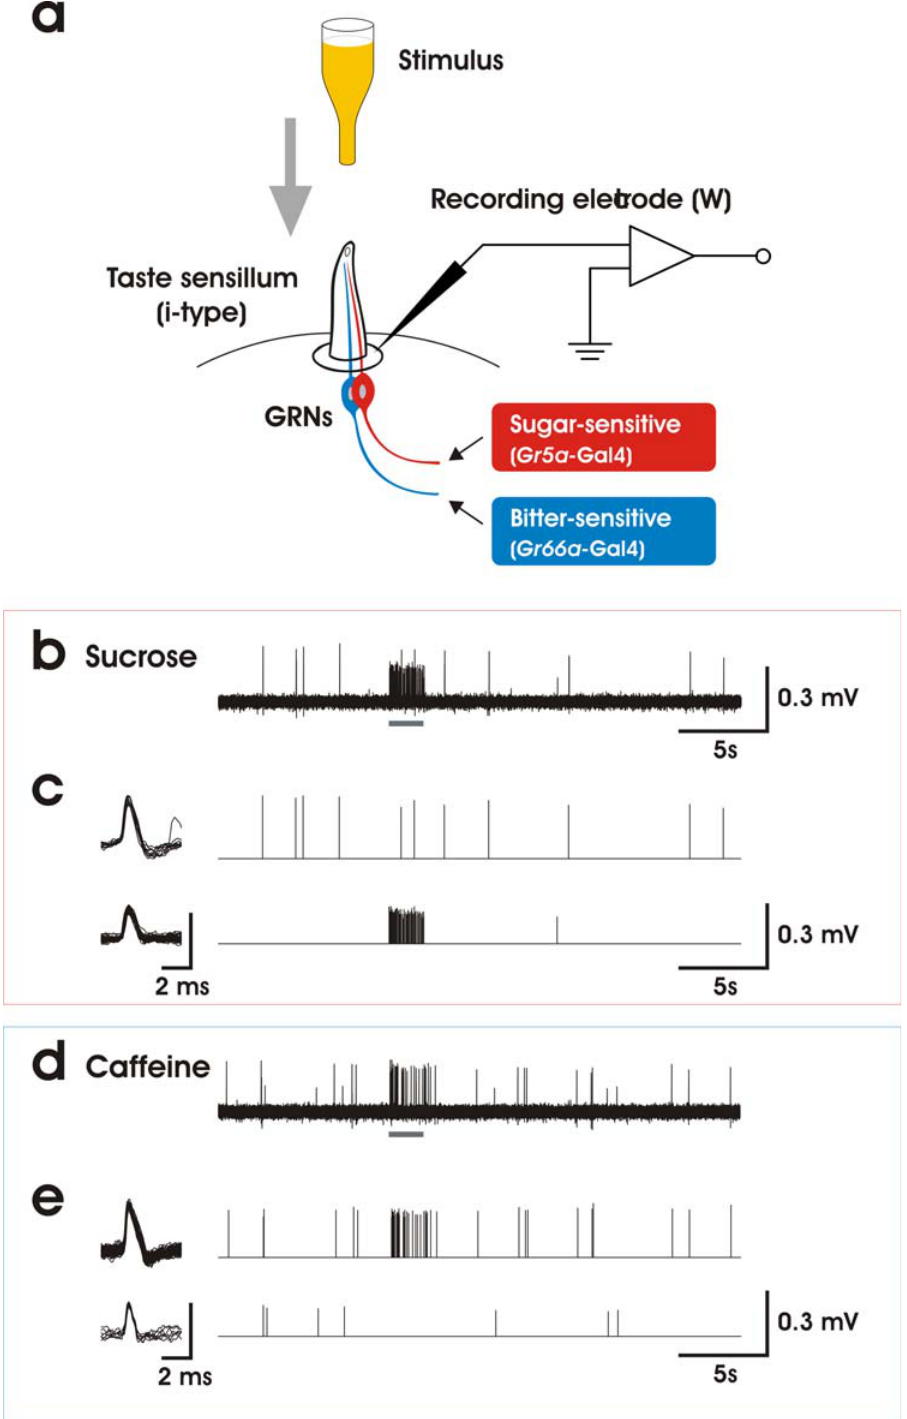
Figure 1. Electrophysiological responses of Drosophila i-type taste sensilla to sugar and bitter substances. a. Schematic diagram of the recording setup. Electrical signals were recorded from an electrolytically sharpened tungsten electrode inserted through the cuticle at the base of a taste sensillum. To stimulate the GRNs, the tip of the sensillum was capped during 2–5 s with a glass capillary filled with a stimulating solution. The i- type sensilla house only two GRNs, which elicit spikes of different amplitudes that were separated using custom software routines (23) as shown in 1c and 1e. The sugar-sensing GRN expresses Gr5a and the bitter-sensitive GRN expresses Gr66a [40]. b. Sample recording with 100 mM sucrose (stimulus=2 s horizontal grey bar). c. Sucrose elicits a response only in the cell that fires spikes of smaller amplitude (lower trace); superimposed spikes (left column) and time-series extracted (central trace and bars) after software spike separation. d. Sample recording with 1 mM caffeine. e. Caffeine elicits a response only in the cell that produces spikes of larger amplitude. Vertical bars=0.3 mV.